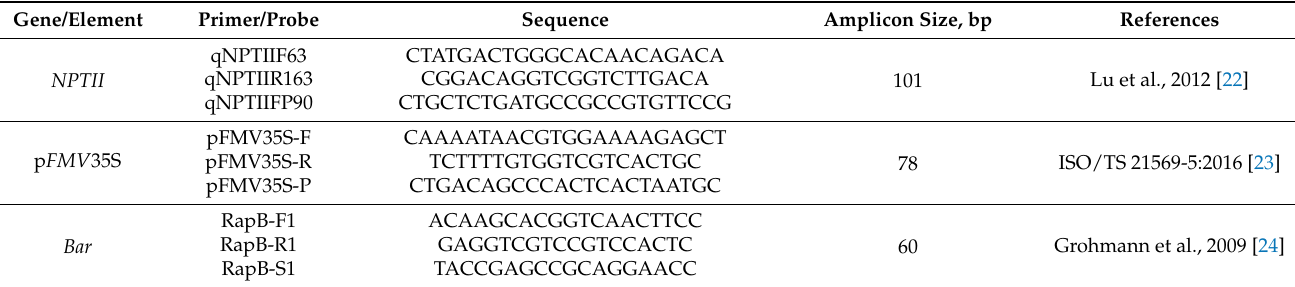
Table 1. Selected primer/probe sets for digital polymerase chain reaction (dPCR)